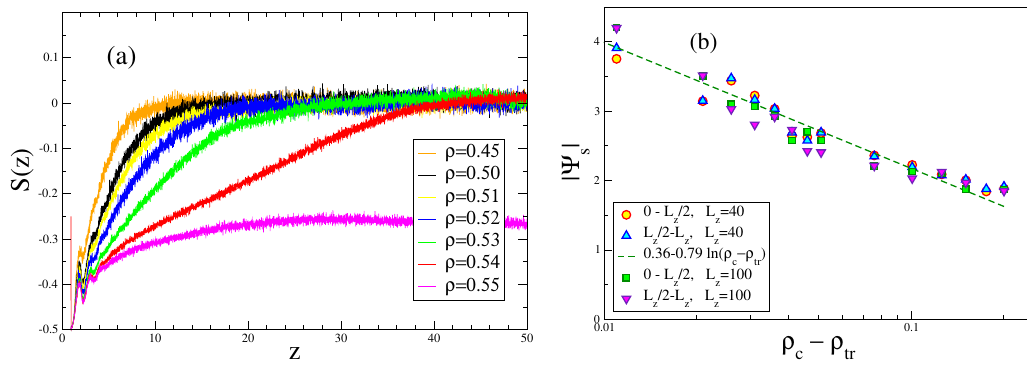
Figure 9. ( a ) Plot of the local order S ( z ) vs. z for the case N = 8, (cid:101) b = 100, L z = 100, where ρ tr = 0.55, as obtained from MD; ( b ) Plot of the surface excess order parameter | Ψ s | , with Ψ s = vs. ρ tr − ρ , for the case N = 16, where ρ tr = 0.30, using data for L z = 40 and L z = 100 (to check for finite size effects) and displaying data for Ψ s extracted from the range from z = 0 to L z /2, as well as from z = L z /2 to L z , to illustrate the large statistical scatter. The straight line illustrates the fit to a logarithmic variation, | Ψ s | = 0.36 − 0.79ln ( ρ tr − ρ ) . Reproduced from [43] with the permission